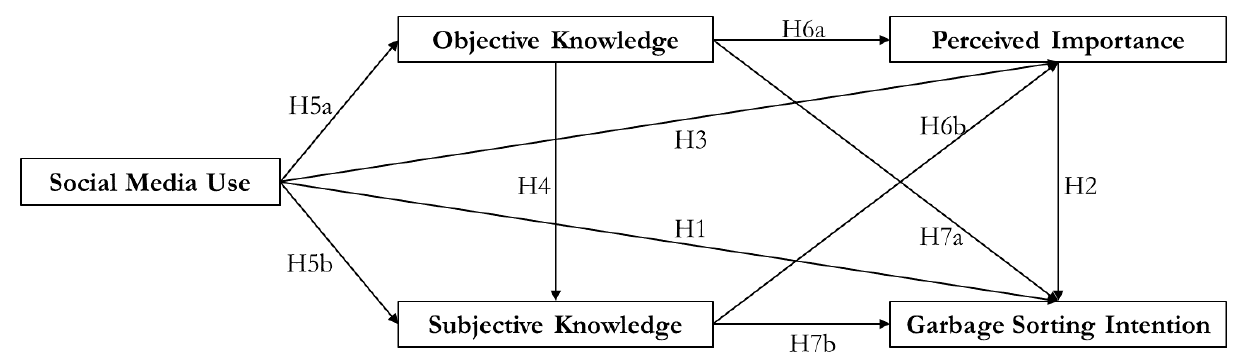
Figure 1. Proposed research model.